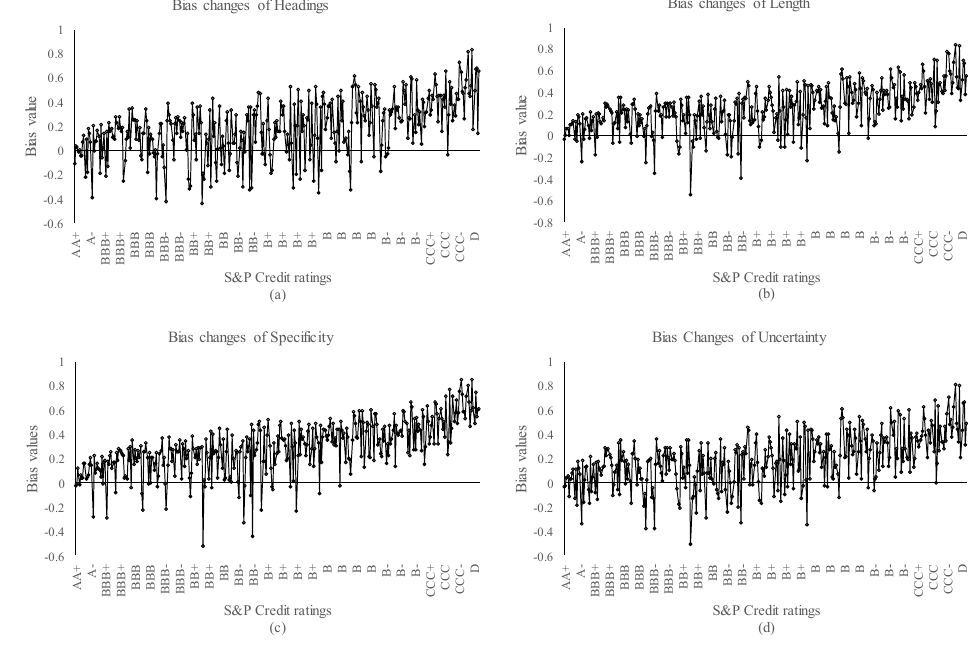
Figure 3. The bias of four internal risk measures under different rating grades.